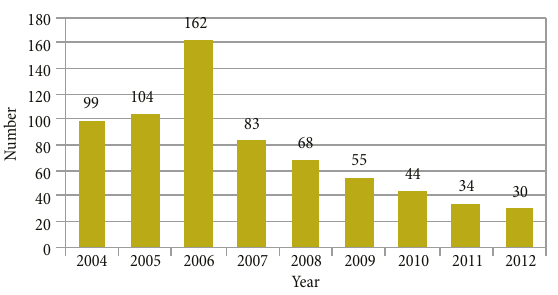
Fig. 4. Traffic incidents in railway transport in